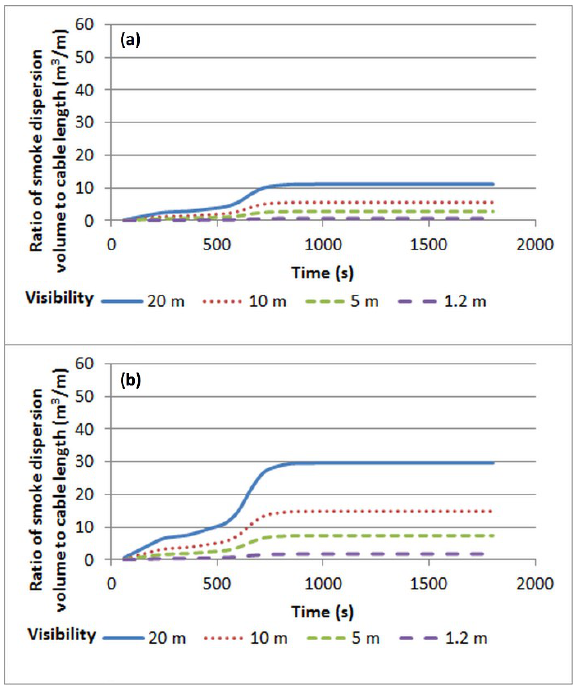
Figure 6. Critical ratios of smoke volume to length of the burning J-H(St)H cable, by which the visibility of signs drop to 20, 10, 5 and 1.2 m for: ( a ) light-emitting signs; ( b ) light-reflective signs.